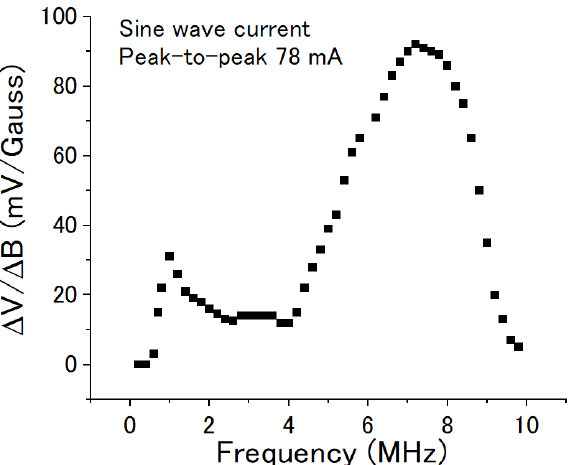
Figure 7. Voltage/field transfer coefficient ∆ V/ ∆ B of the coil vs the frequency of the sine wave current. The peak-to-peak amplitude of the current was kept at 78 mA.